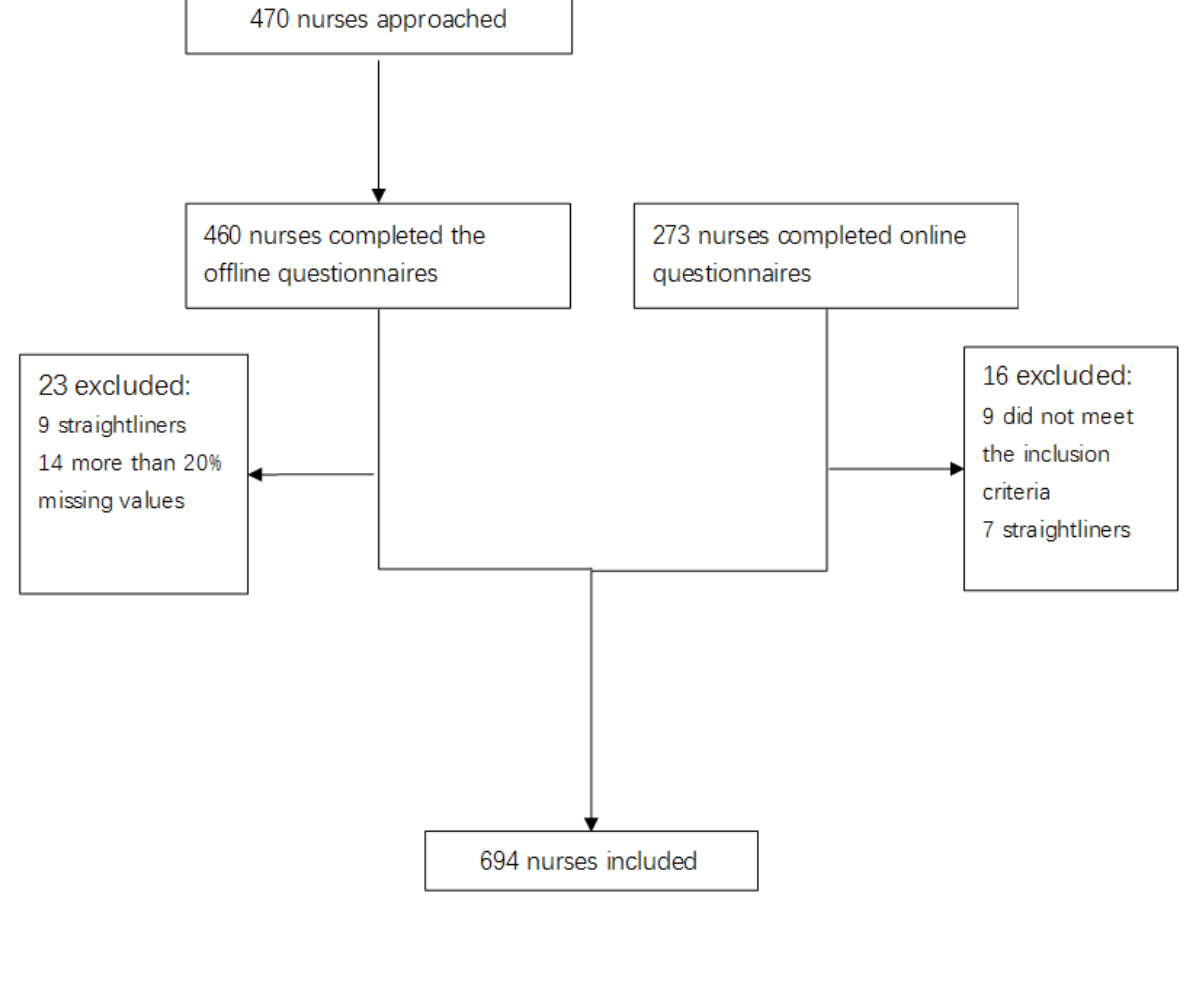
Figure 1. Flow diagram of the participants recruitment and questionnaires